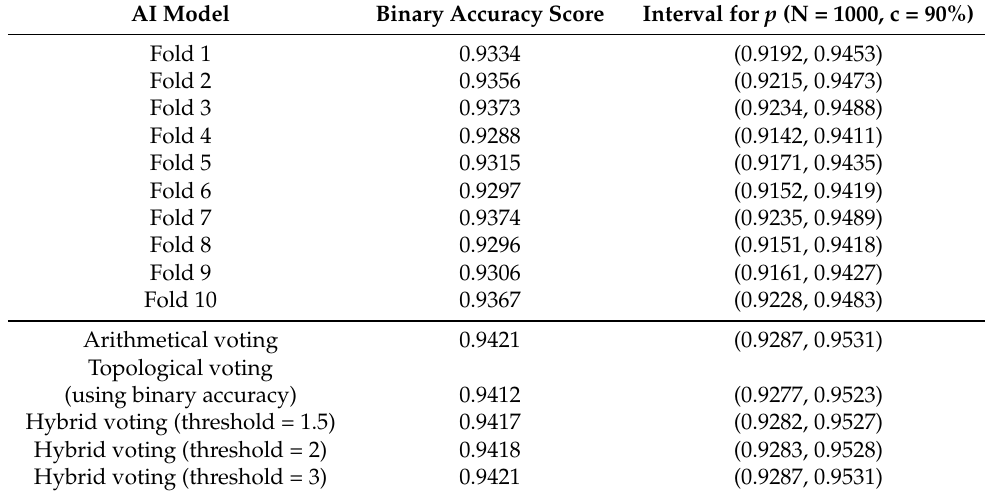
Table 3. Comparison of voting methods on 10 folds for the Salt dataset, using binary accuracy